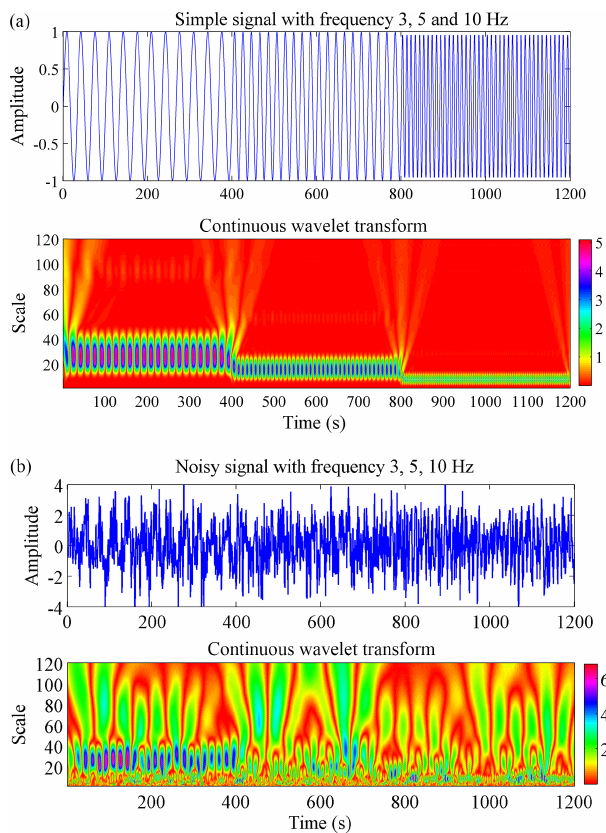
Figure 2. (a) The continuous wavelet transform (CWT) using syn- thetic time series data and (b) the CWT of synthetic noisy time se- ries data.